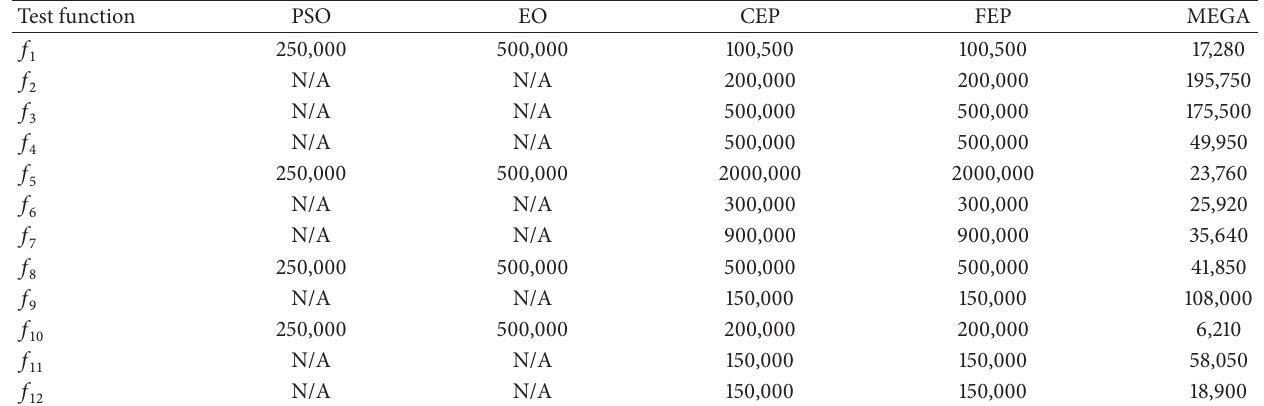
Table 4: Comparison of the computational effort (MNFE) with other